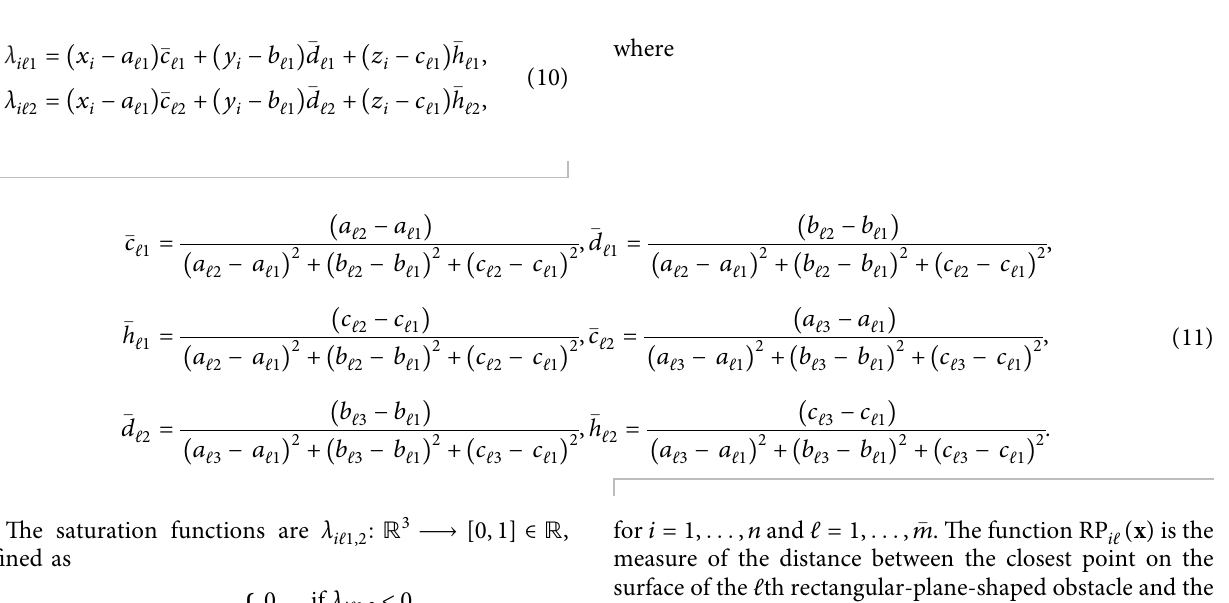
Figure 4: The 3D visualization of the attractive potential fields and the analogous contour plot (50 contours) generated using the target attractive function, equation (4). (a) 3D visualization. (b) Contour